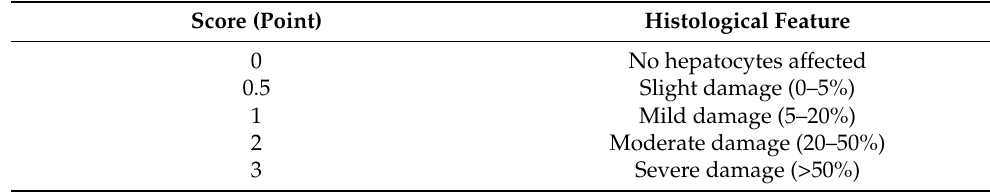
Table 1. Liver steatosis damage